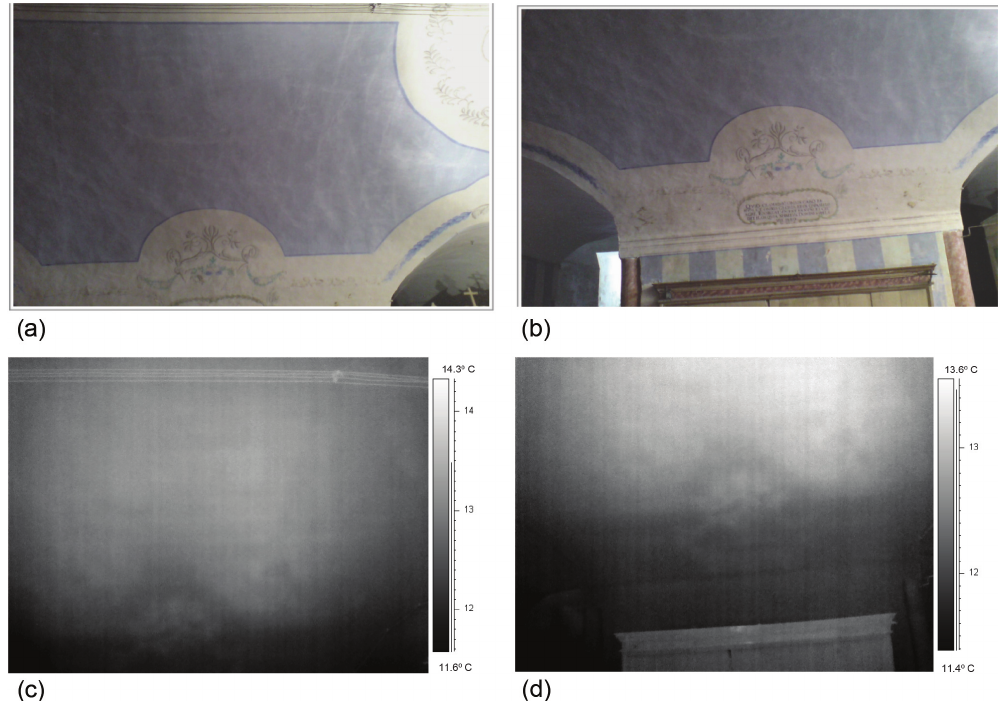
Figure 10. The IRT investigated areas in the nave of the Church of Santa Croce (panel a and panel b ), IRT images relative to the photos of panels (a) and (b) (panel c and panel d